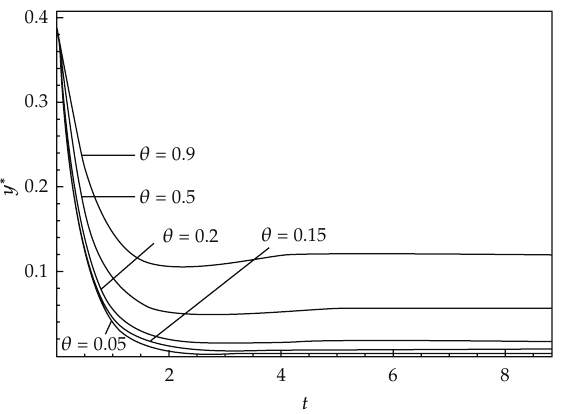
Figure 5: Size of infected class for di ff erent values of θ for β 10 (cid:3) 0 . 2, β 10 (cid:3) 0 . 4, λ 0 (cid:3) 0 . 1, α 10 (cid:3) 0 . 2, γ 0 (cid:3) 0 . 1, and μ (cid:3) 0 .